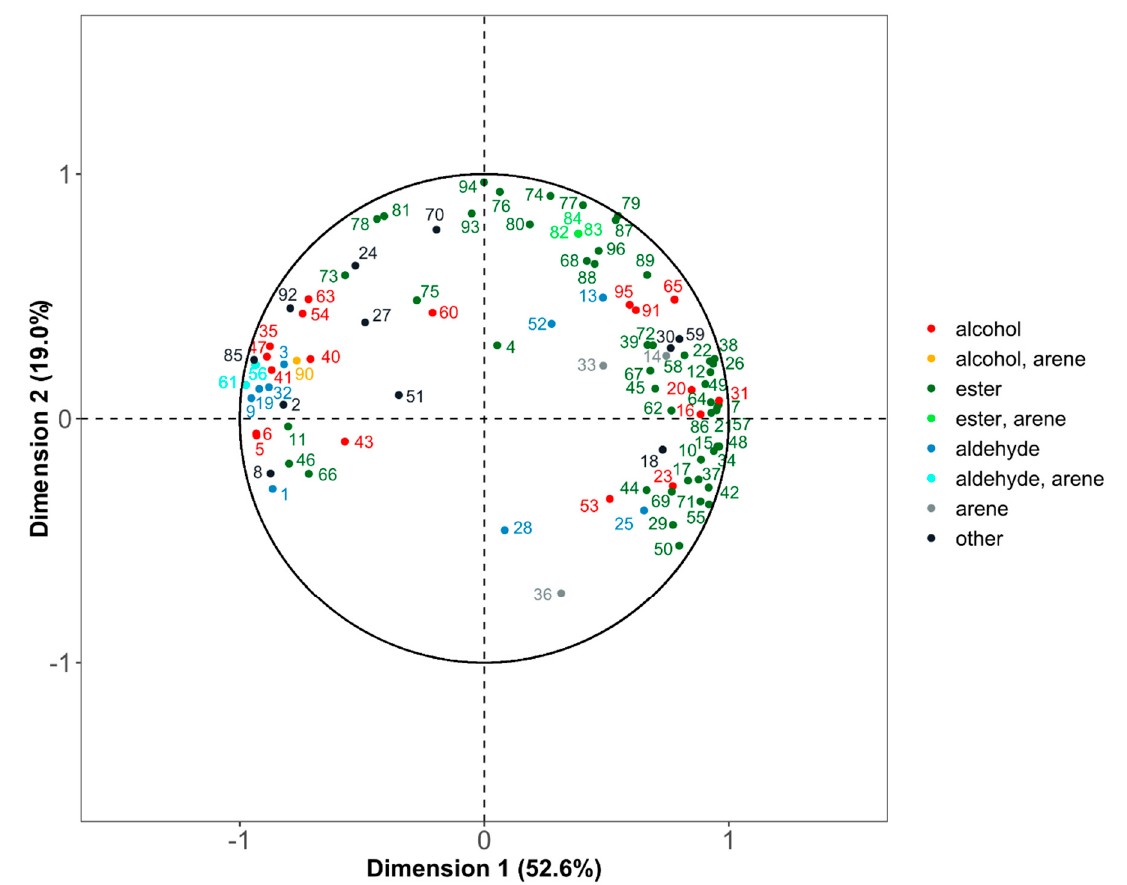
Figure 5. PCA loading plot from the analysis of the peak areas of 96 compounds present in nine new make whisky spirits. Loadings are shown in the form of chemical grouping of the compounds (numbering of the compounds is detailed in Table A2 (Appendix A)).